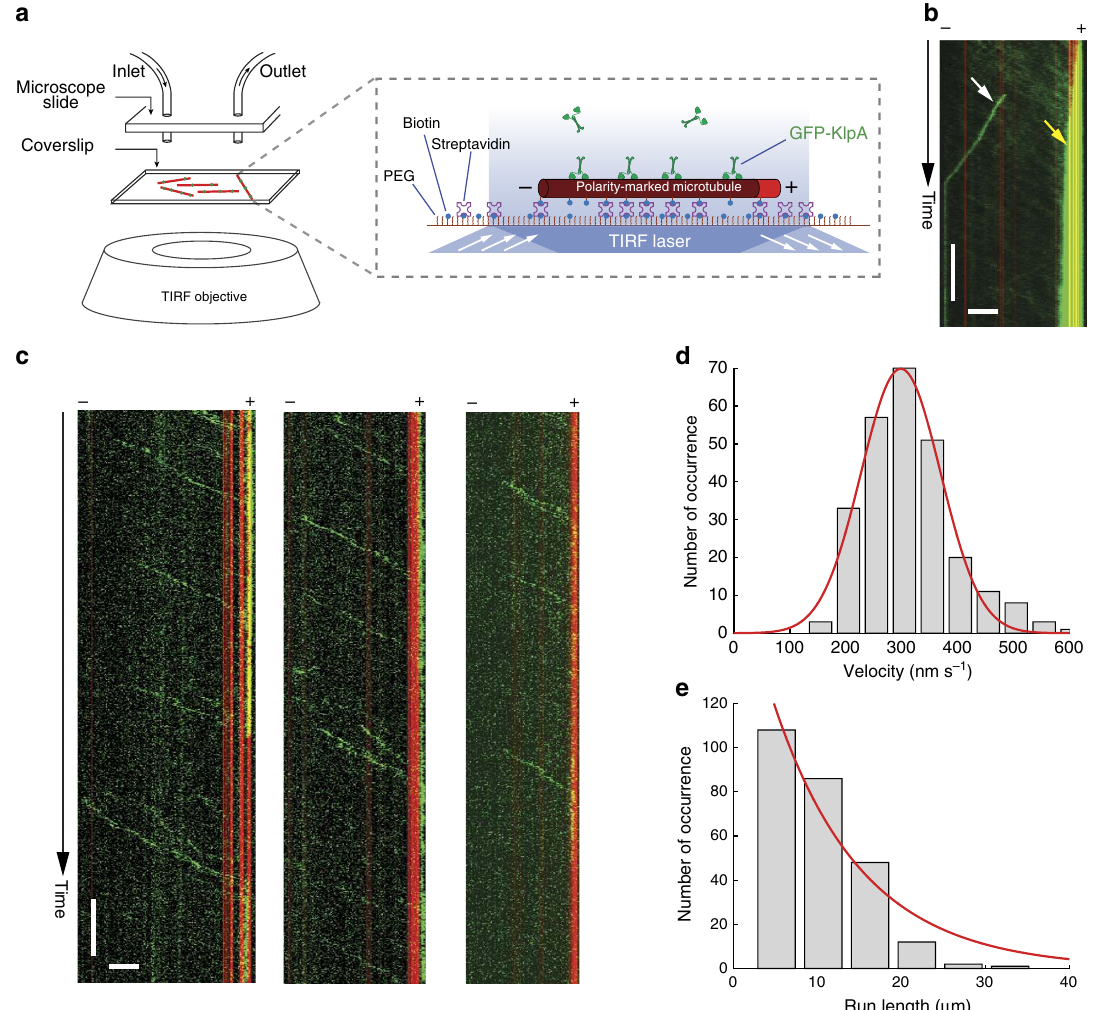
Figure 2 | KlpA moves processively towards the plus end on single microtubules. ( a ) Schematic diagram of the in vitro KlpA motility assay. Microtubules were fluorescently labelled with Hilyte 647, and polarity-marked with a dim minus end and a bright plus end. ( b ) Example kymograph showing GFP-KlpA molecules (green), at relatively high protein input levels, form a plus end-directed flux and accumulate there on a surface-immobilized polarity-marked microtubule (red). Yellow arrow indicates GFP-KlpA accumulation at the microtubule plus end, and white arrow indicates minus end-directed movement of a GFP-KlpA aggregate. ( c ) Example kymographs showing that individual GFP-KlpA molecules (green) move towards the plus end on single polarity-marked microtubules (red) in a processive manner. ( d ) Velocity histogram of individual GFP-KlpA molecules on single microtubules. Red line indicates a Gaussian fit to the velocity histogram. ( e ) Run-length histogram of individual GFP-KlpA molecules on single microtubules. Red line indicates a single exponential fit to the run-length histogram. Scale bars, 1min (vertical) and 5 m m